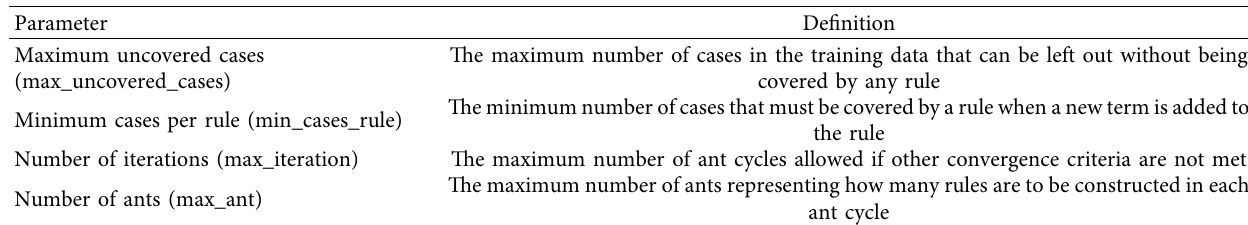
Figure 4: A generic high-level pseudocode for AntMiner algorithms. Table 3: Definitions of commonly used parameters in AntMiner